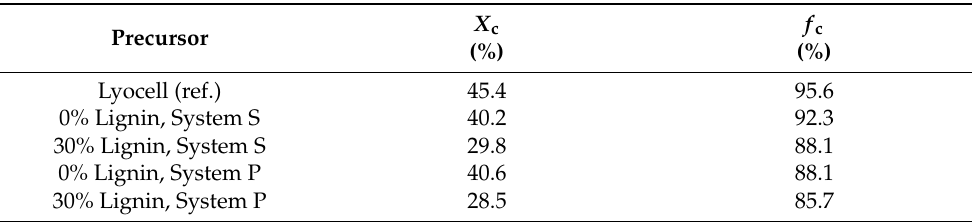
Table 3. Degree of crystallinity (X c ) and degree of crystalline orientation ( f c ) of the precursors with 0 and 30 wt% lignin from Systems S and P.